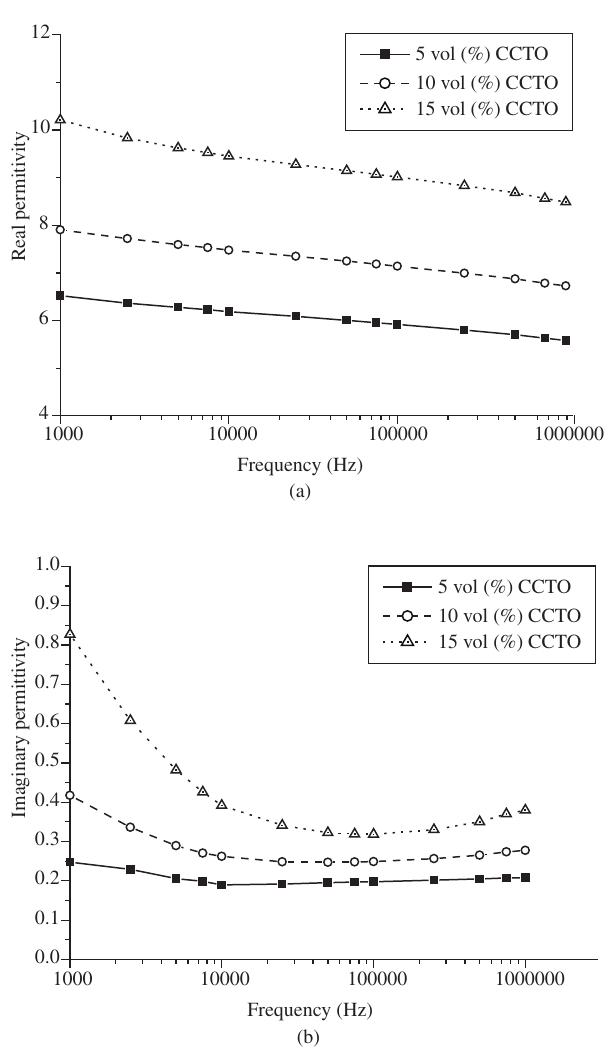
Figure 2. a) Real and b) imaginary permittivity vs. frequency for composites with different CCTO volume fraction (Temp. 30